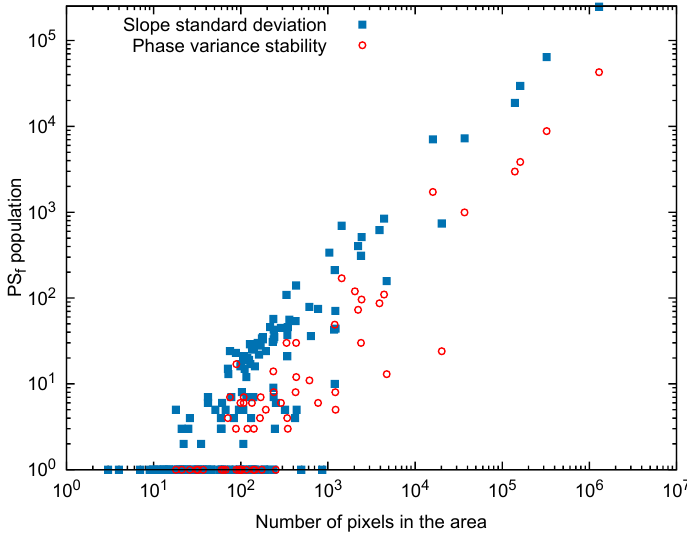
Figure 9. PS f population as a function of the size of the area, for both artificially and naturally disconnected areas. Regions with no PS f are not represented. Axes are in logarithmic